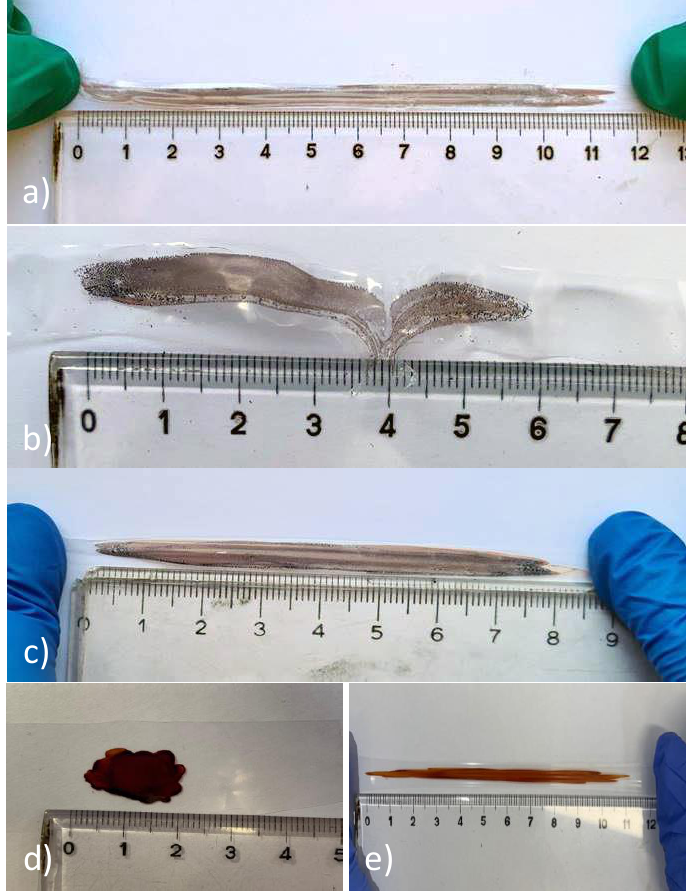
Figure 9. Stretching of the final product, ( a ) PEDOT- g -PAU 30, ( b ) PEDOT- g -PAU 50, ( c ) PEDOT- g - PAU 100, ( d ) PEDOT- g -PAU 150 before stretching; ( e ) PEDOT- g -PAU 150 stretched at cca